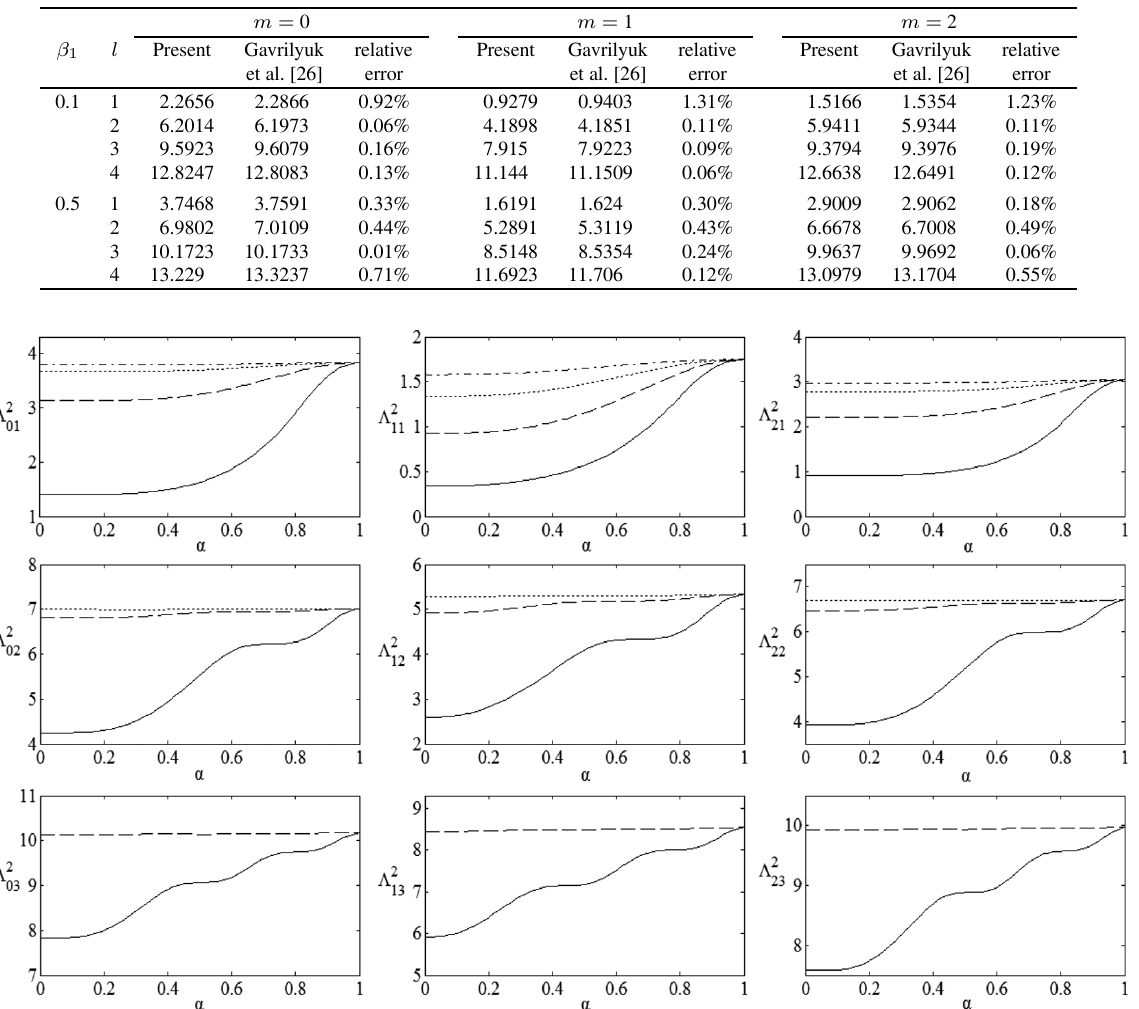
Table 4 Comparison study of Λ 2 ml ( m = 0, 1, 2, l = 1, 2, 3, 4) for α = 0.7, β 2 = 0.5